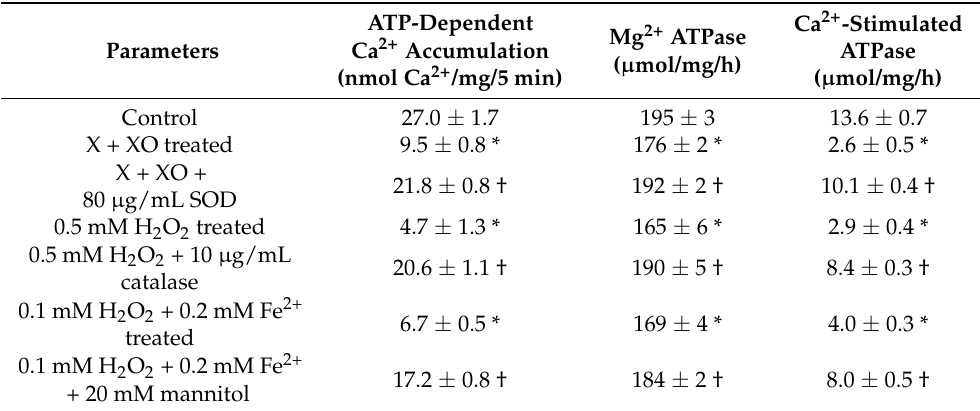
Table 2. Modification of ATP-dependent Ca 2+ accumulation, Mg 2+ ATPase and Ca 2+ -stimulated AT- Pase activities in cardiac sarcolemma upon incubation for 30 min with different oxyradical generating systems in the absence or presence of their scavengers.